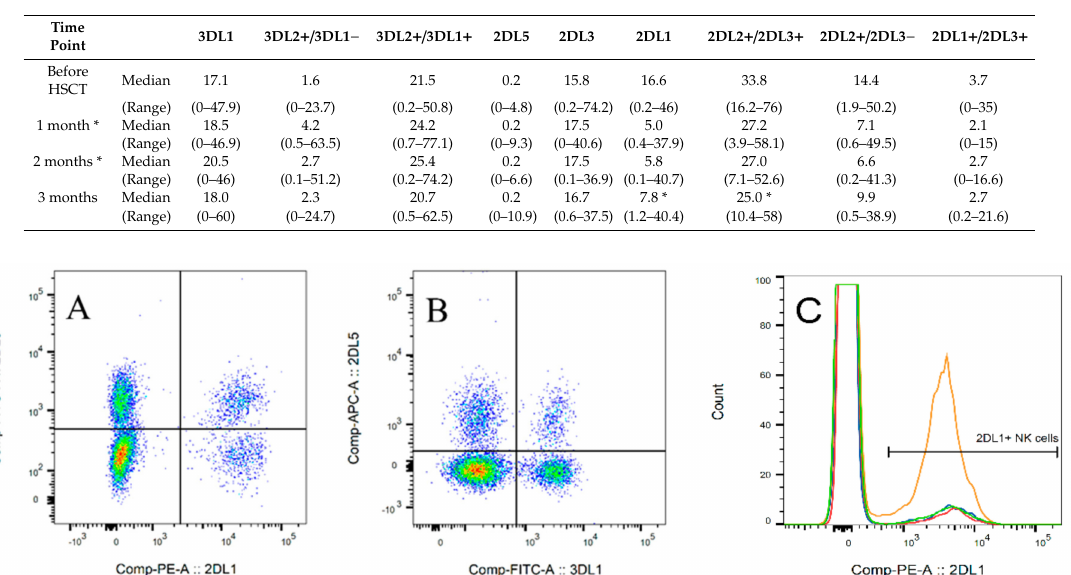
Table 2. Percentage of iKIR positive NK cells (%). All iKIRs were di ff erent when the percentages of positive NK cells before HSCT and 1 and 2 months after HSCT were compared. Statistically significant results ( p < 0.05) are denoted by *.